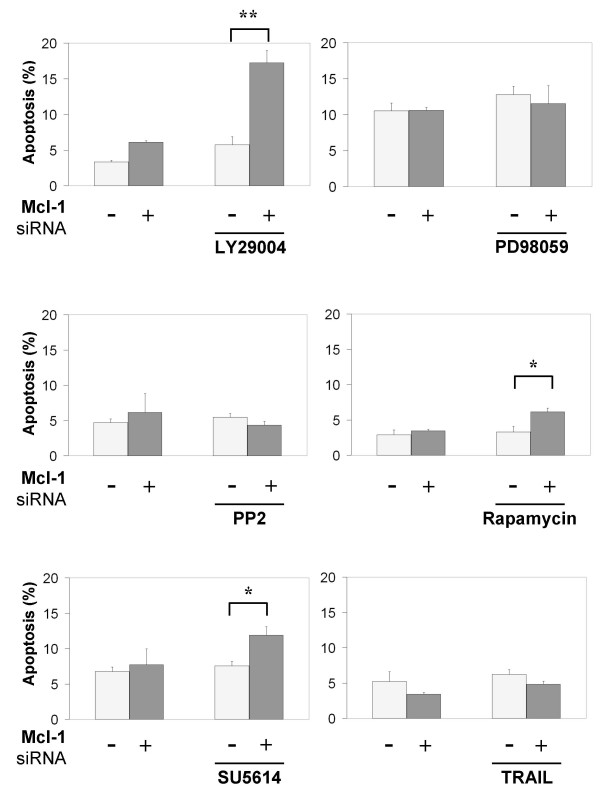
Apoptosis sensitivity of HCC cells towards different kinase inhibitors and TRAIL after downregulation of Mcl-1. Huh7 cells were treated for 24 h with different kinase inhibitors (LY294002, 25 μM; PD98059, 50 μM; PP2, 10 μM; rapamycin, 50 pM; SU5614, 15 μM; and TRAIL, 100 ng/ml). Cells were transfected 24 h before with siRNA specific for Mcl-1 (40 nM, "Mcl-1 siRNA +") or with siRNA specific for green fluorescent protein as a control (40 nM, "Mcl-1 siRNA -"). Apoptosis was determined by FACS analysis according to Nicoletti [29]. Values are means + SD. *p < 0.01, **p < 0.001.